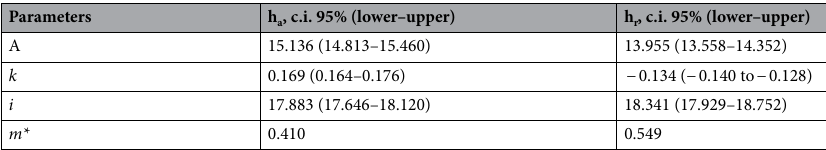
Table 2. Values of the parameters of the first half of Richard’s curve fitted for the hours of activity (h a ) and hours of restriction (h r ) on air maximum temperature (T a, max ) of L. montanezi . A (asymptote), k (rate), i (inflection point) and m (shape) using nonlinear least squares (‘nls’ function R-stats) with ‘modpar’ and ‘SSposnegRichards’ of the R-package ‘FlexParamCurve’. The 95% c.i. were determined with the function ‘confint2’ of the R-package ‘nlstools’ 108 . The m parameter is estimated from the data and fixed to allow others to behave as free parameters.